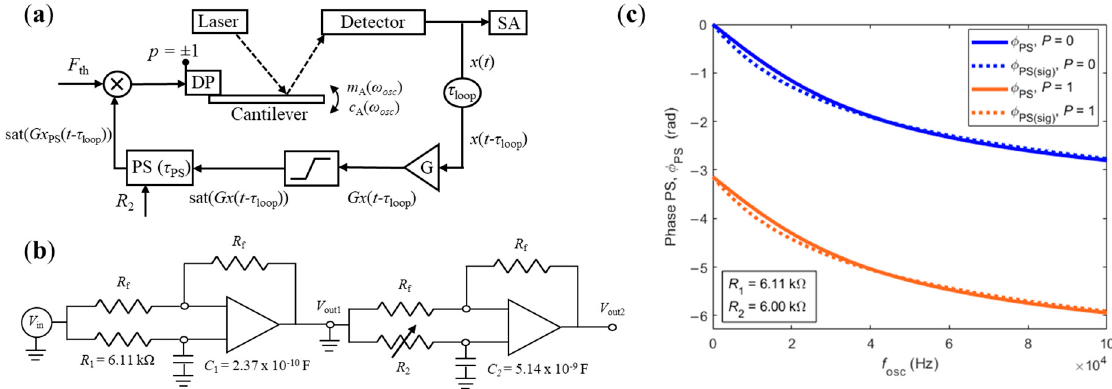
Figure 1. ( a ) Schematic of the experimental setup. The deflection of the cantilever is detected by a four-quadrant detector, naturally delayed, amplified, saturated, controllably delayed with an adjustable Phase-Shifter (PS), and, finally, fed back to the exciting piezo. ( b ) Schematic of the two-stage PS. The second stage was used to control the imposed shift in the feedback loop with the potentiometer R 2 . ( c ) Phase-shift introduced by the PS shown in (b) as function of the oscillation frequency of the closed-loop given by the transfer function (Equation (2), solid lines) and the sigmoid approximation (Equation (3), dashed lines), for different polarities of the piezo.